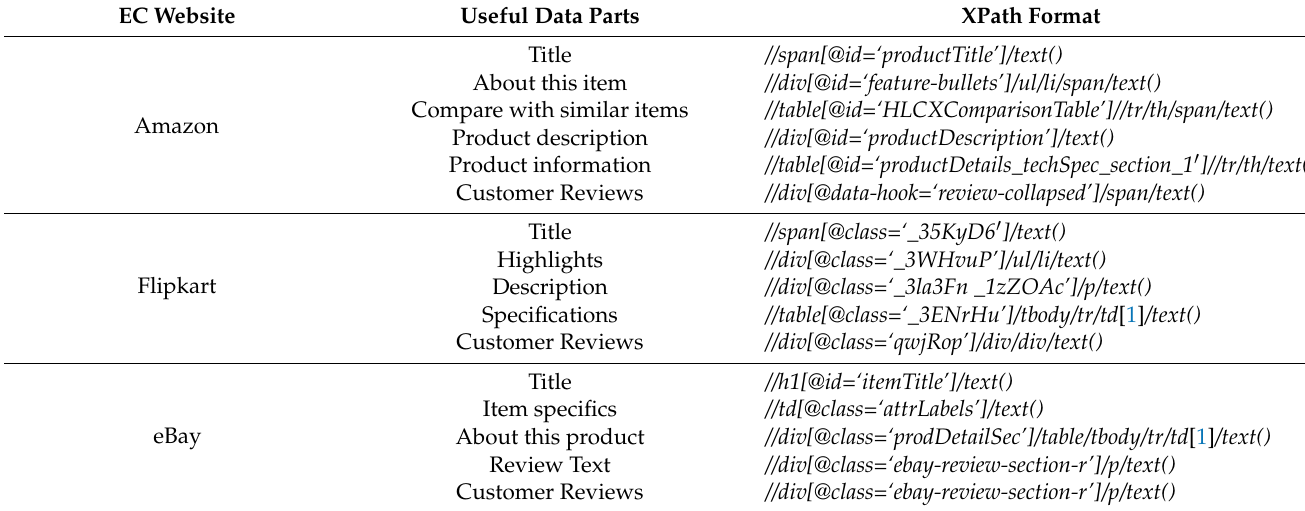
Table 1. Samples of different structures in the top five e-commerce (EC)